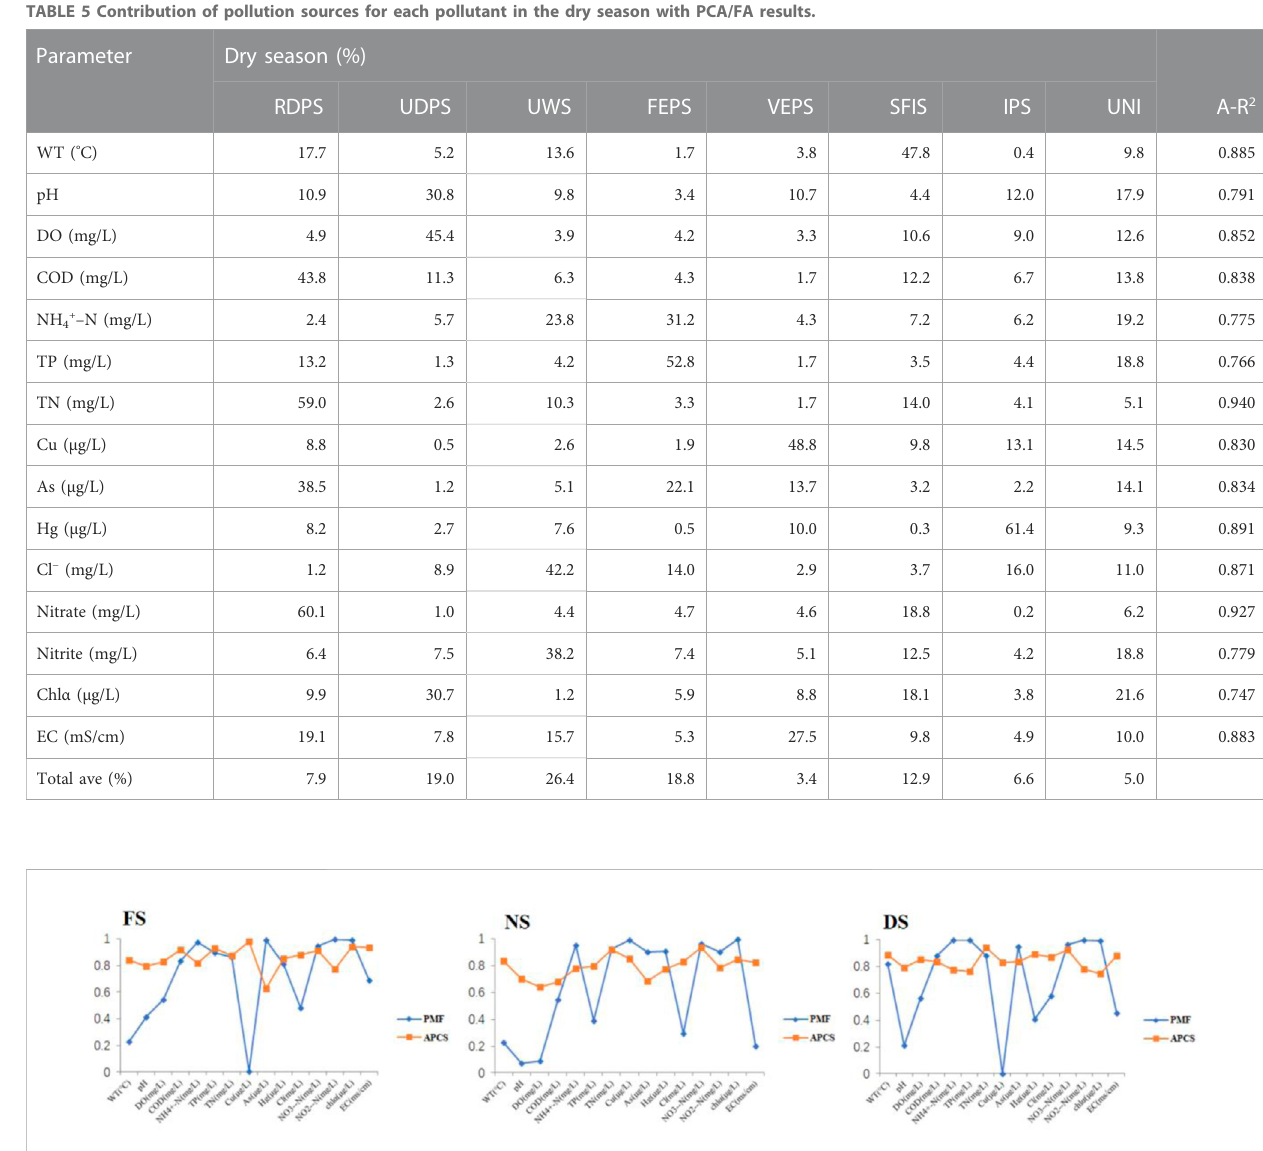
Line graphs of R 2 values in FS, NS, and DS using the APCS – MLR and EPA PMF